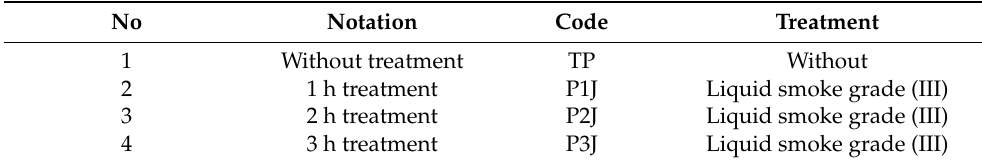
Table 1. Treatment notation on BSFs.